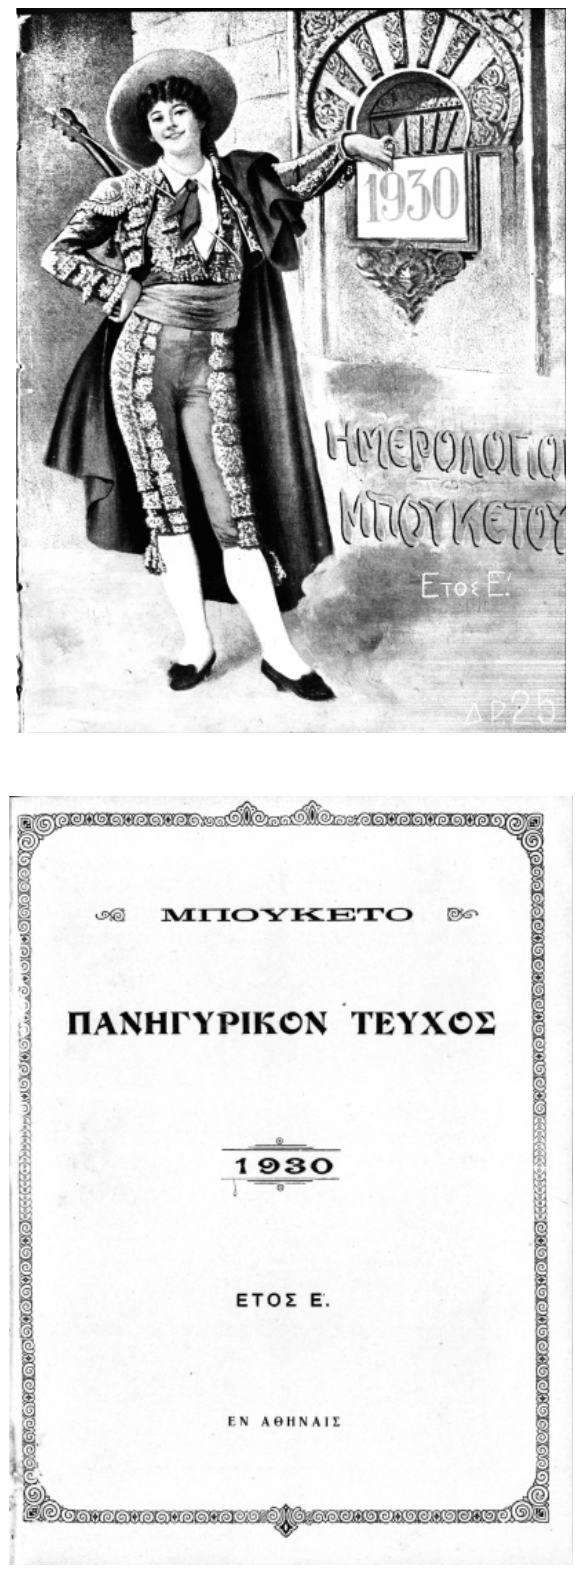
Figs 3 and 4 Ημερολόγιον του Μπουκέτου . Cover of and page title of volume 5